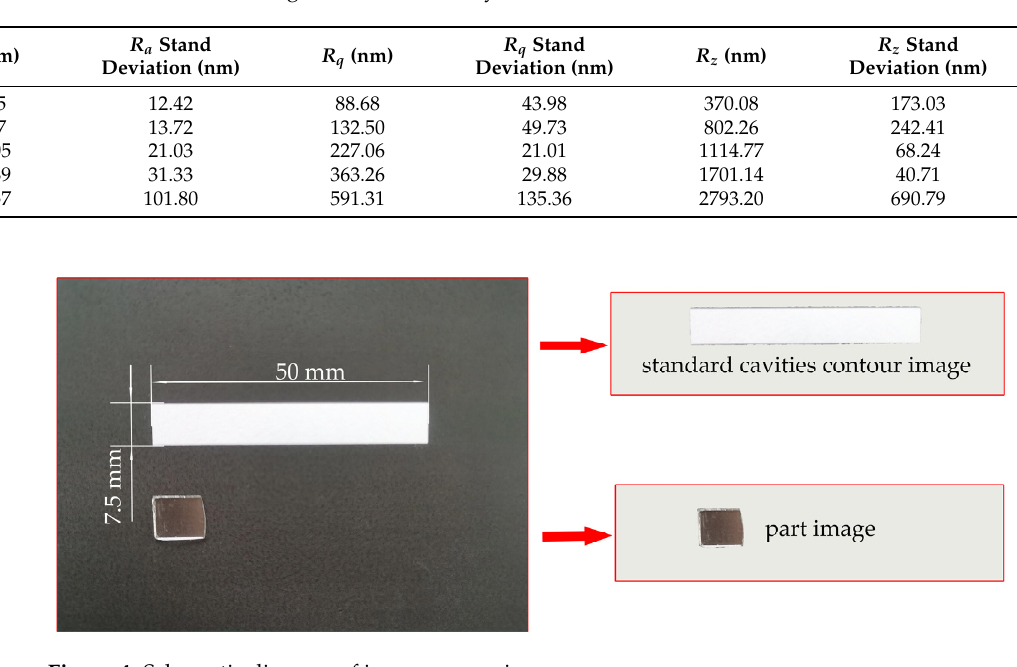
Table 3. The surface roughness of each cavity surfaces.